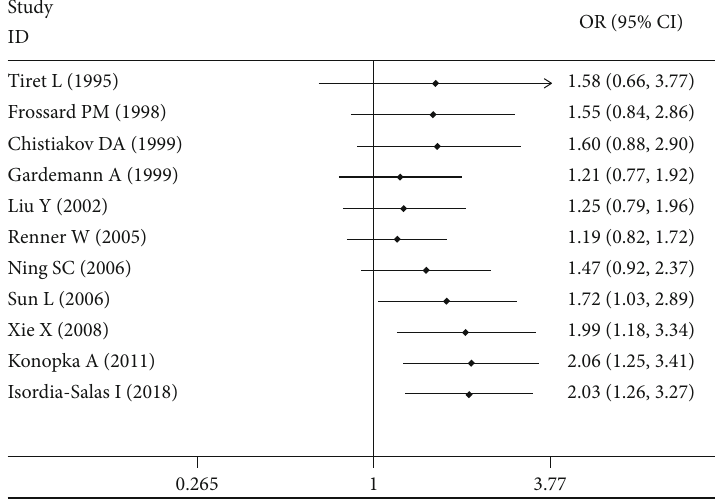
Figure 5: Forest plot of cumulative analysis over time of AGT p.Thr174Met polymorphism associated with myocardial infarction using a recessive genetic model (MM vs.